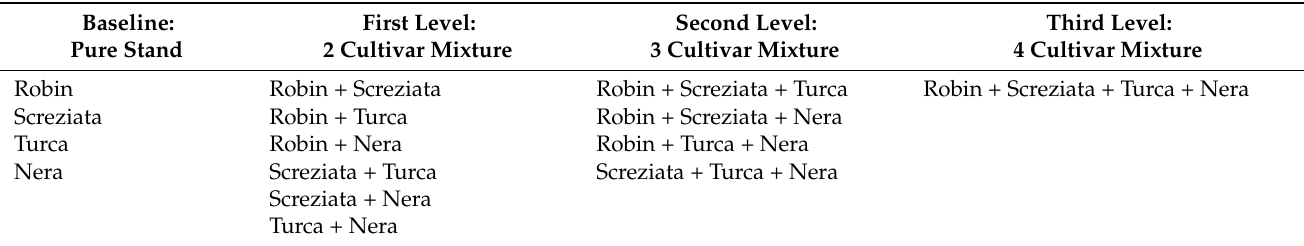
Table 1. Increasing levels of diversity within lentil mixture